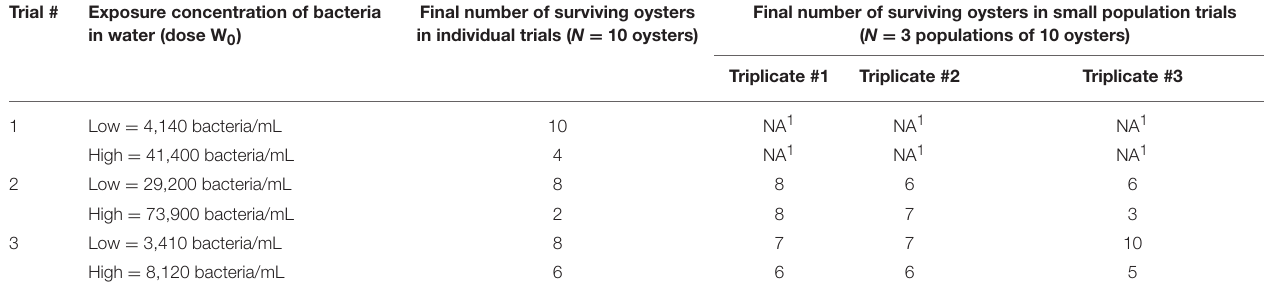
TABLE 2 | Observed final (12 dpe) number of surviving oysters in the laboratory transmission trials. Trial